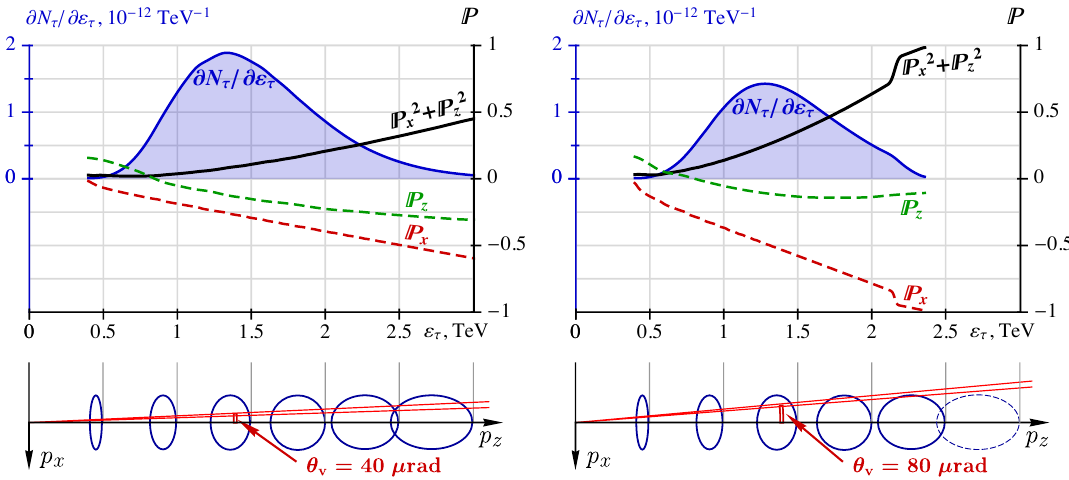
Figure 7 . Polarisation and spectra of de(cid:13)ected (cid:28) leptons for (left) (cid:18) v = 40 (cid:22) rad and (right) (cid:18) v = 80 (cid:22) rad. The spectra are normalised to one initial proton. The red and green dashed lines represents the x and z components of the averaged (cid:28) polarisation.